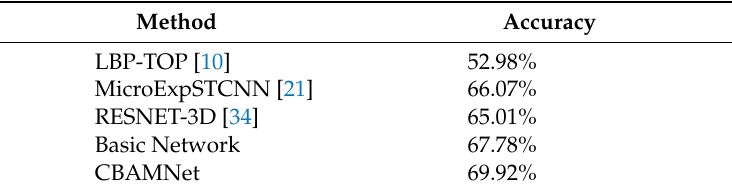
Table 4. Comparison of average recognition rates of di ff erent methods. LBP-TOP: local binary patterns on three orthogonal planes; MicroExpSTCNN: xxx; RESNET-3D: Residual Network-3D; CBAMNet: convolutional block attention module